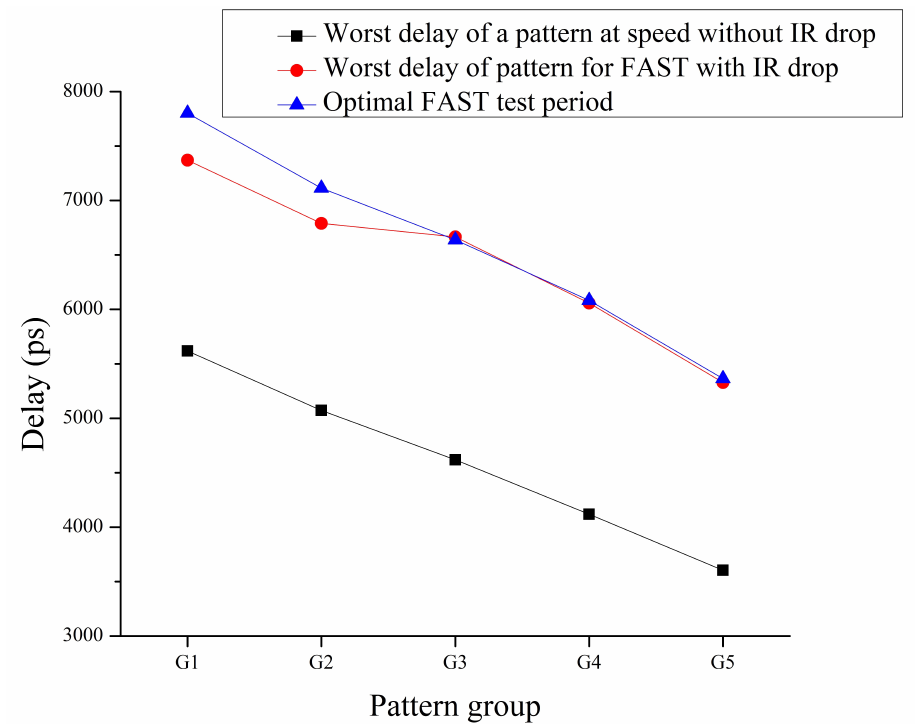
Figure 9. Comparison of maximum path delay of a pattern in each test group for at-speed test, FAST with IR drop effect